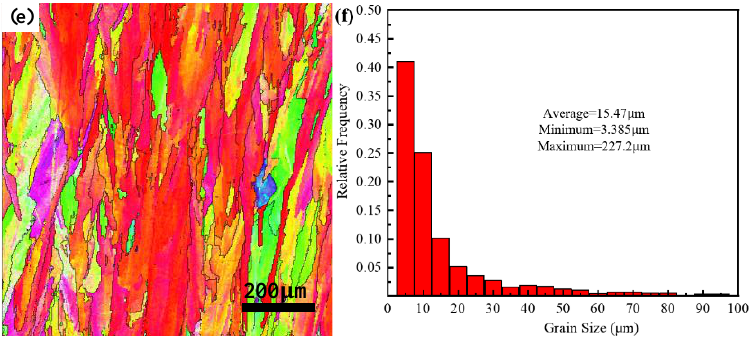
Figure 5. The grain morphology and size ( a , b ) VED = 60 J·mm −3 , ( c , d ) VED = 96 J·mm −3 , and ( e , f ) VED = 119 J·mm −3.